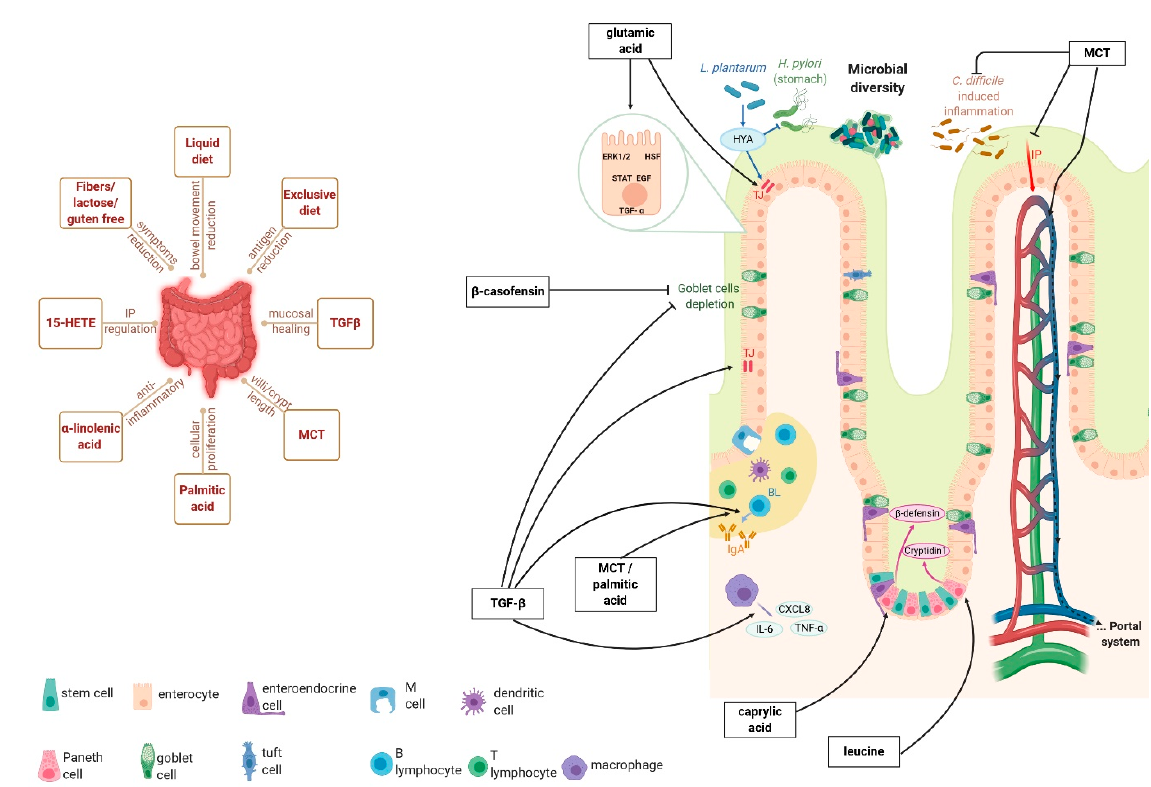
Figure 1. Mechanisms of action of Modulen ® on intestinal epithelium. The left panel represents the consequences of a liquid, exclusive, and fibers/lactose/gluten-free diet, as well as TGF(transforming growth factor-beta) MCT (medium-chain triglycerides), palmitic acid, α -linolenic acid, and 15-HETE (15-hydroxyeicosatetraenoic acid);. The right panel focuses on leucine, caprylic, glutamic and palmitic acid, MCT, TGF- β , and β